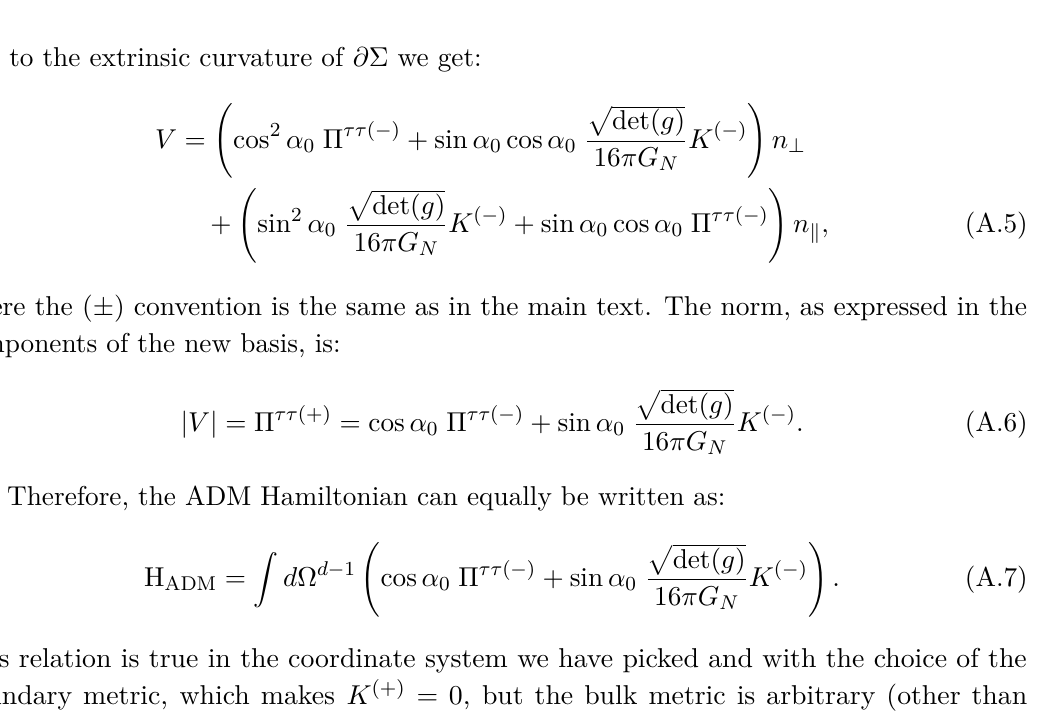
Figure 13 . This shows a bulk Cauchy slice Σ in the neighbourhood of its junction with the boundary at ∂ Σ . The submanifold ∂ Σ is a codimension-two surface and so has a two-dimensional space orthogonal to it. Two different bases of this space are